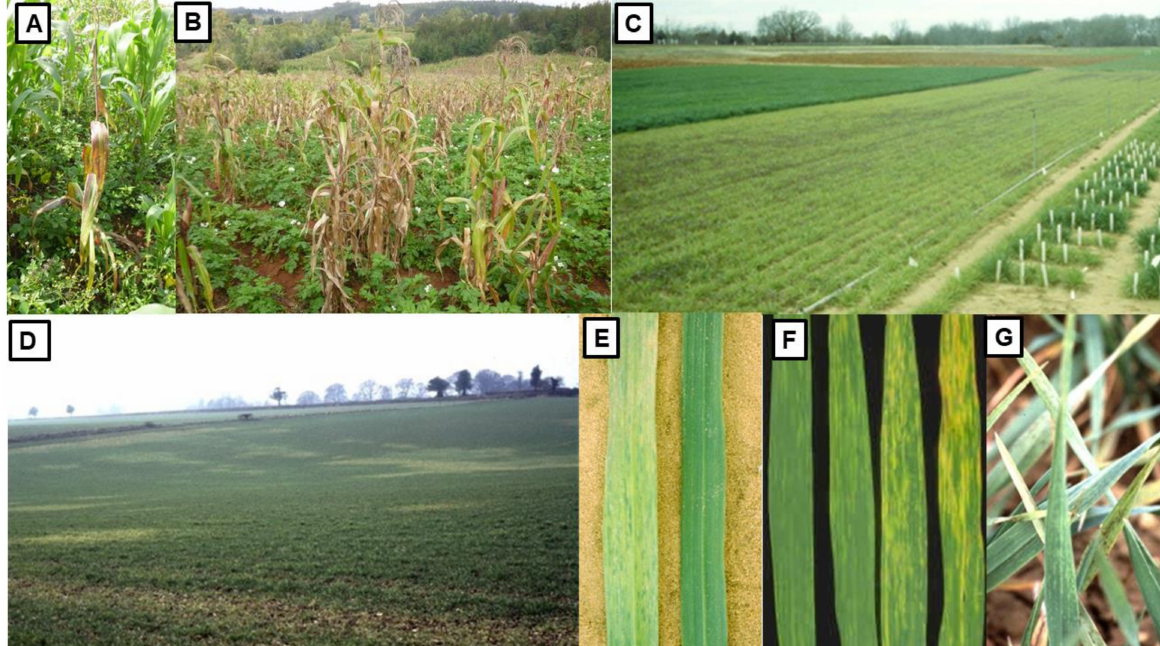
Figure 7. Examples cereal virus disease threats of concern for Australia. ( A ) Maize plant dying from maize lethal necrosis disease (center), surrounding maize plants healthy. ( B ) Smallholder maize crop in Kenya destroyed by maize lethal necrosis disease (all maize plants dying or killed), potato understory crop unaffected. ( C ) Wheat plots and rows exposed to soil-borne wheat mosaic virus (SBWMV) infection in the field in the USA: plants of susceptible cultivar (central plot) and breeding lines (bottom right rows) show leaf chlorosis and stunting whereas plants of resistant cultivar (top left plot) and breeding lines (bottom right rows) show heathy vigorous growth. ( D ) Barley field in the UK showing irregular shaped patches of chlorotic, dwarfed plants caused by infection with a mixture of barley yellow mosaic virus (BaYMV) and barley mild mosaic virus (image credit: Rothamsted Experimental Station/M. Adams). ( E ). Wheat leaf infected with SBWMV showing chlorotic leaf streaking (left) versus healthy leaf (right) ( F ) Wheat leaves infected with wheat spindle streak virus showing ‘spindle-shaped’ streaks. ( G ) Leaves of barley plants infected with BaYMV showing chlorotic streak and blotch symptoms (image credit: Rothamsted Experimental Station/M. Adams). Images modified: ( A ) from [53] ( B ) from [8]; ( C , E , F ) from [326]; ( D , G ) from [324]. Image credits ( C , E ) @Oklahoma State University/R.M. Hunger; ( D , G ) @ Rothamsted Experimental Station/M. Adams; ( F ) @University of